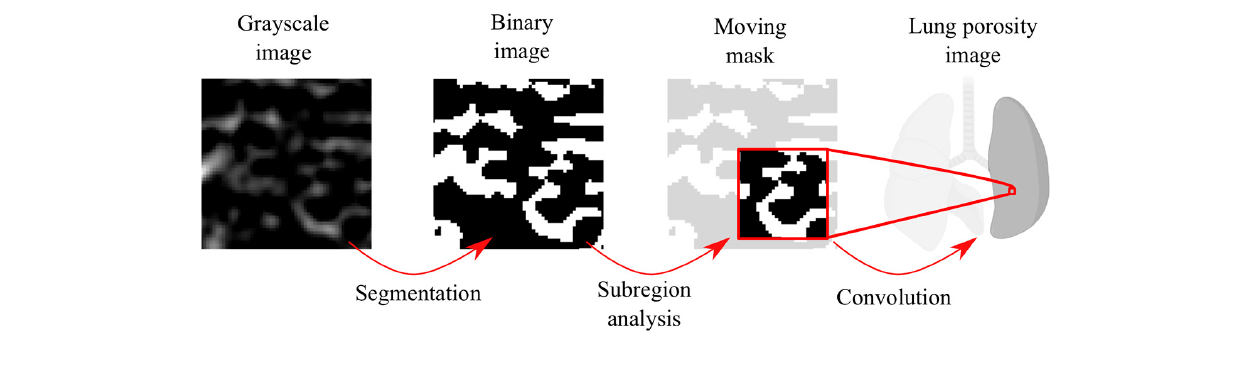
FIGURE 1 | Workflow for the construction of alveolar porosity